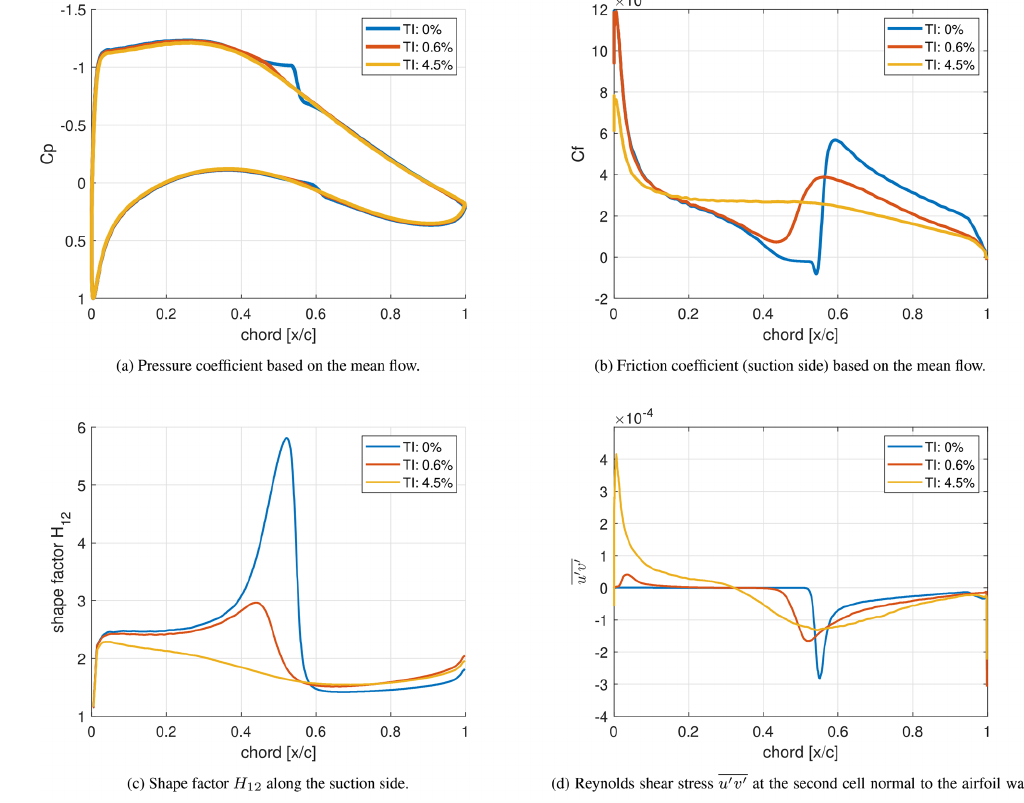
Figure 18. Distribution of the aerodynamic properties of the airfoil from the LES (geometry corresponds to the LM 43P blade at a radius of 35m from the hub) at a Reynolds number of 10 6 and α = 4 ◦